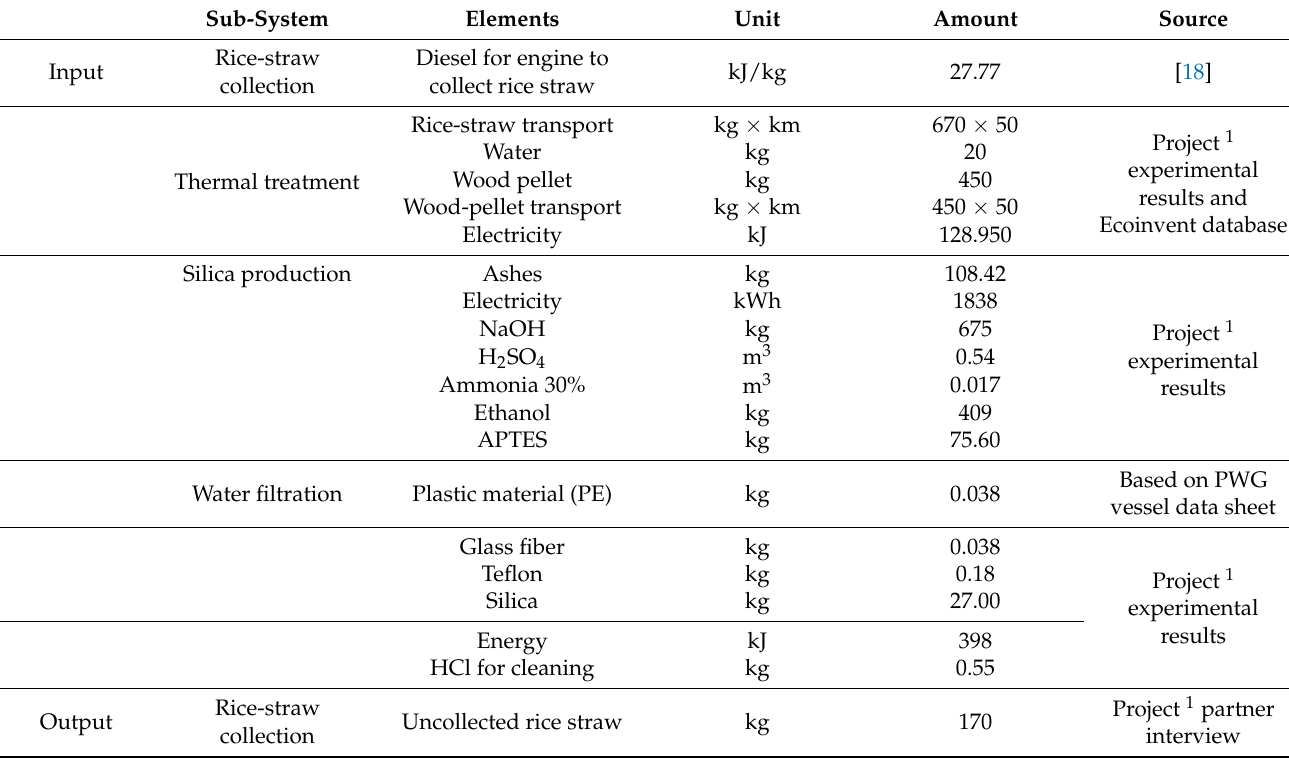
Table 1. Summary inventory data of innovative water-treatment process ( 1 LIFE LIBERNITRATE). All data refer to the functional unit (26 m 3 of